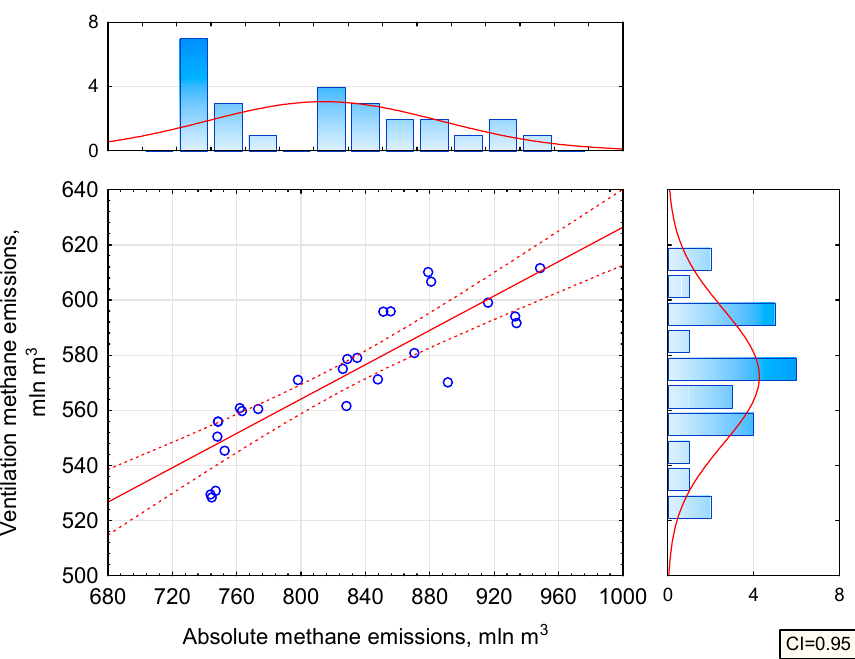
Figure 5. Relationship between absolute methane emissions and ventilation methane emissions in hard coal mines in Poland.